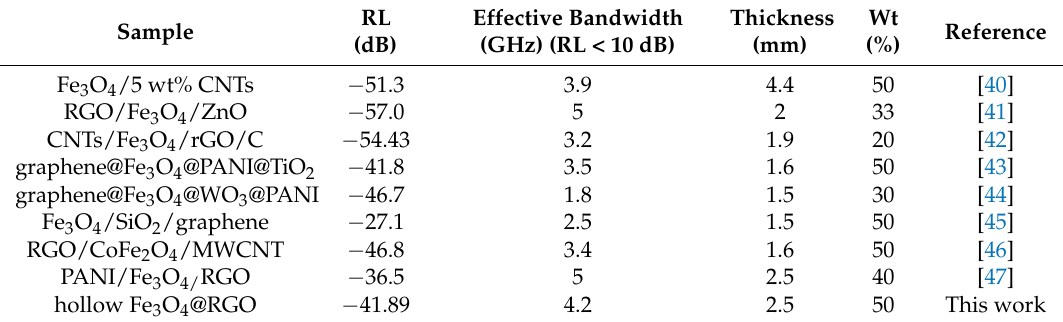
Table 1. Microwave absorption performances of various Fe 3 O 4 nanoparticles in previous reports compared with hollow Fe 3 O 4 @RGO compared with hollow Fe 3 O 4 @RGO composites.